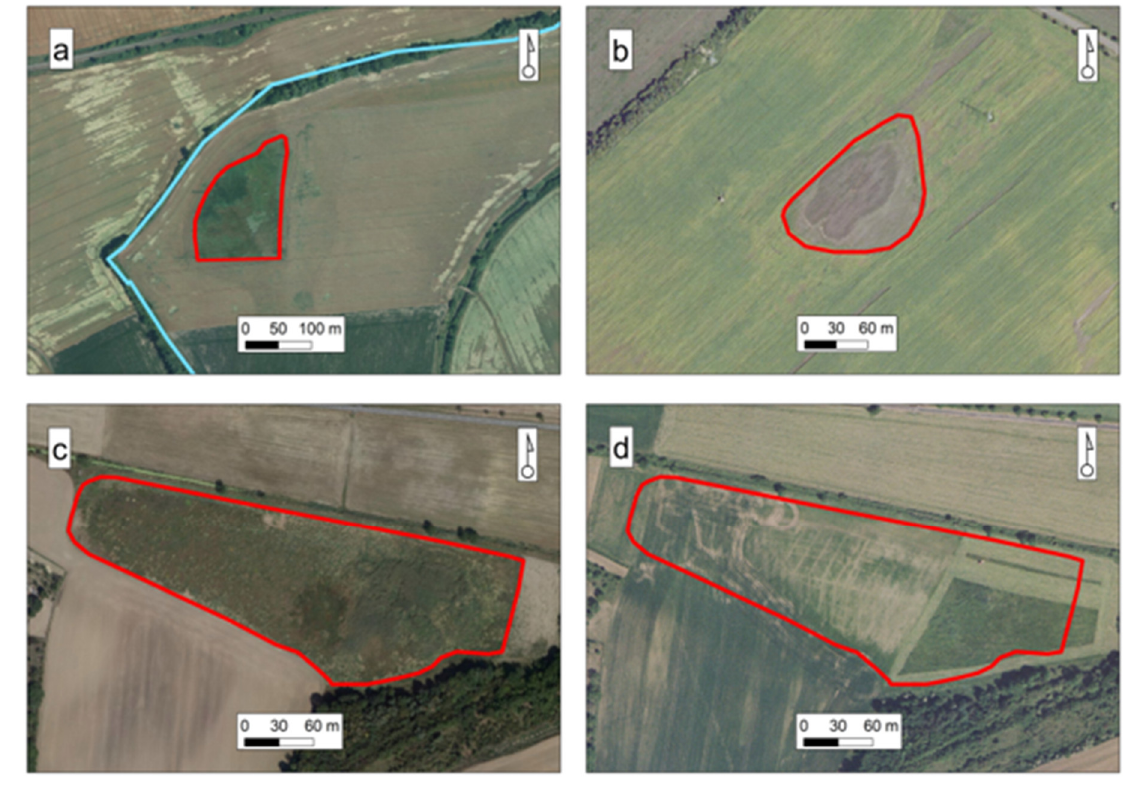
Figure 5. Examples of waterlogged areas in the agricultural landscape: ( a ) a developed field wetland with hygrophilous vegetation surrounded by cereals; ( b ) the initial stage of development of the field wetland, with residual stagnant water on the surface and without wetland vegetation, surrounded by rapeseed; ( c,d ) non-functional subsurface drainage in different years. Red marking represents the borders of the waterlogged areas.